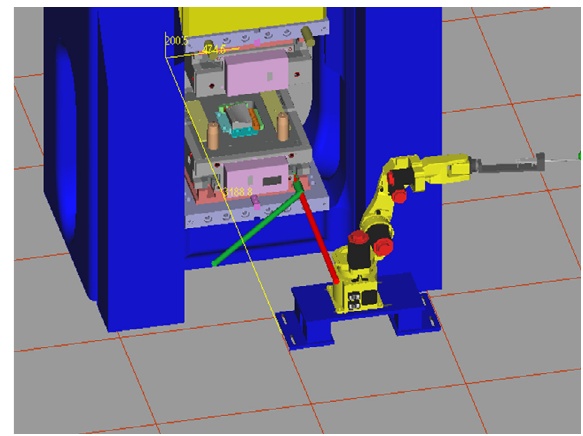
Figure 12. Design of special tool – layout